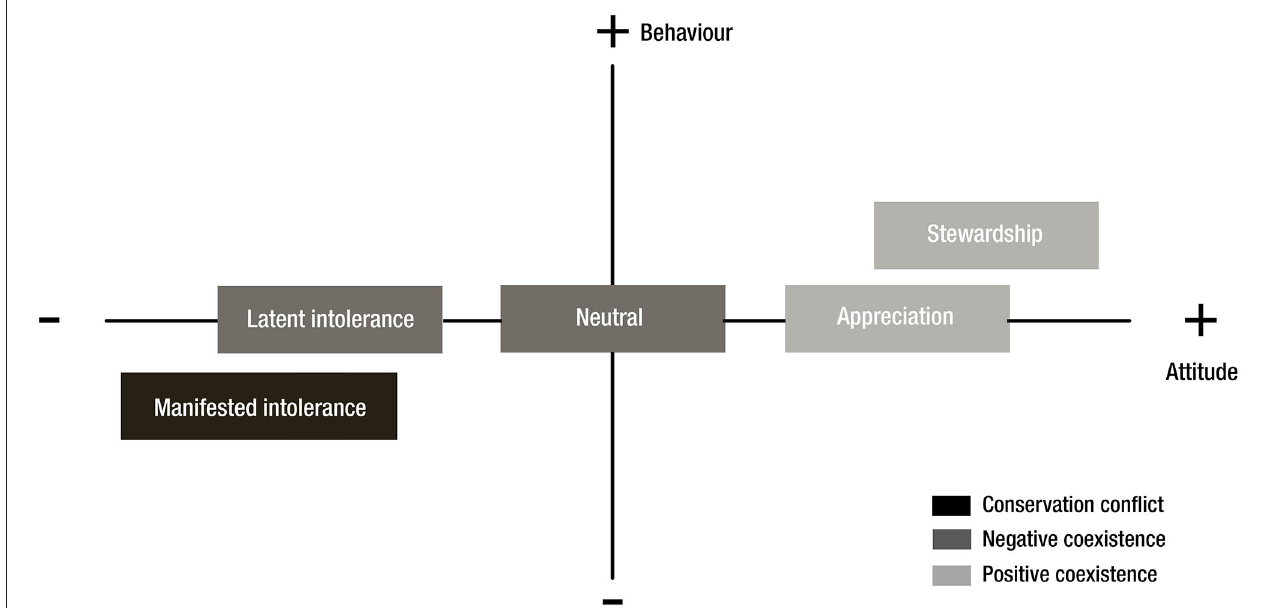
FIGURE 1 | Visual representation of human response to wildlife impacts. Manifested intolerance refers to negative attitudes and behaviors toward wildlife. Latent intolerance comprises responses where attitudes are negative, but behaviors are not. Neutral refers to ambivalent attitudes and behaviors. Appreciation includes responses where attitudes are positive, but without corresponding positive behaviors. Stewardship includes positive attitudes and behaviors [Source: Adapted from Bhatia et al.